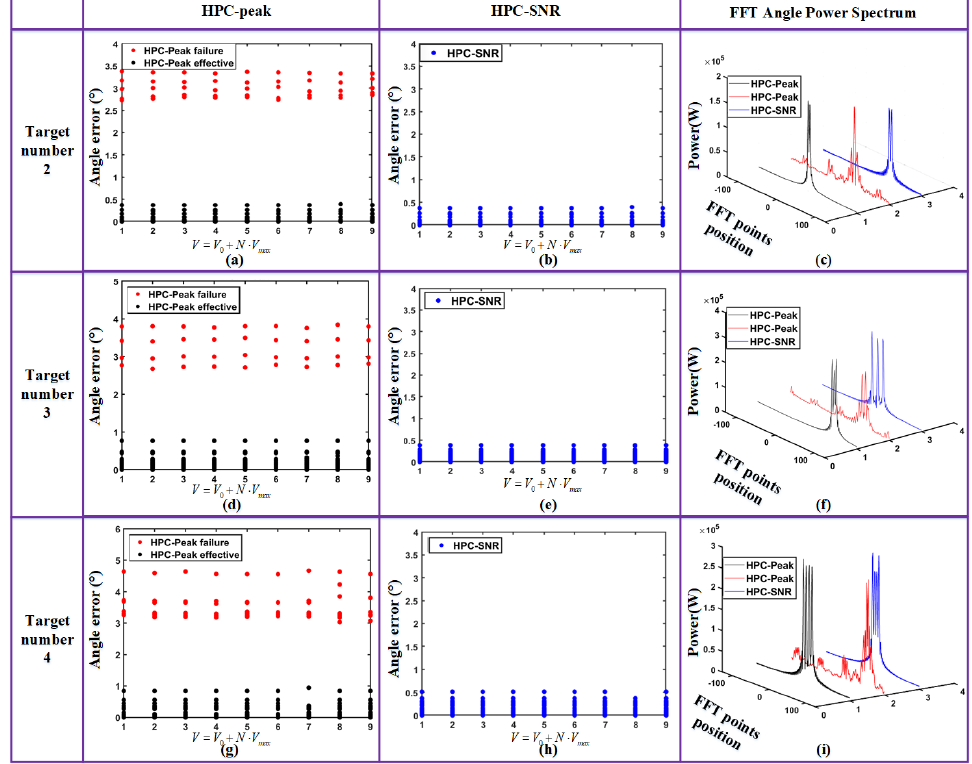
Figure 19. Performance simulation of Velocity disambiguation algorithm in multi-objective situations. ( a ) The angle estimation error of the HPC-Peak in two targets. ( b ) The angle estimation error of the HPC-SNR in two targets. ( c ) The FFT angle power spectrum waveform of the HPC-Peak and the HPC-SNR in two targets. ( d ) The angle estimation error of the HPC-Peak in three targets. ( e ) The angle estimation error of the HPC-SNR in three targets. ( f ) The FFT angle power spectrum waveform of the HPC-Peak and the HPC-SNR in three targets. ( g ) The angle estimation error of the HPC-Peak in four targets. ( h ) The angle estimation error of the HPC-SNR in four targets. ( i ) The FFT angle power spectrum waveform of the HPC-Peak and the HPC-SNR in four